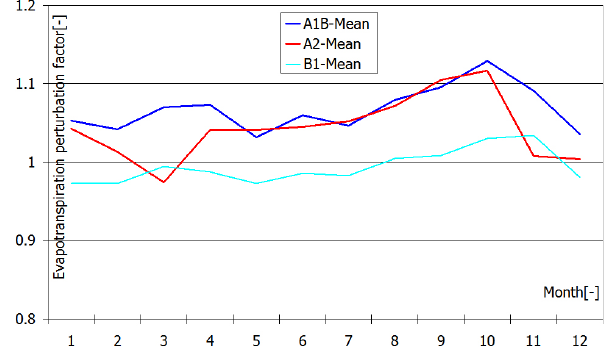
Fig. 9. Comparison of the mean level of perturbation factor of monthly precipitation volume between the WDP and MV methods for A1B emission scenario at BYBLK meteorological station.